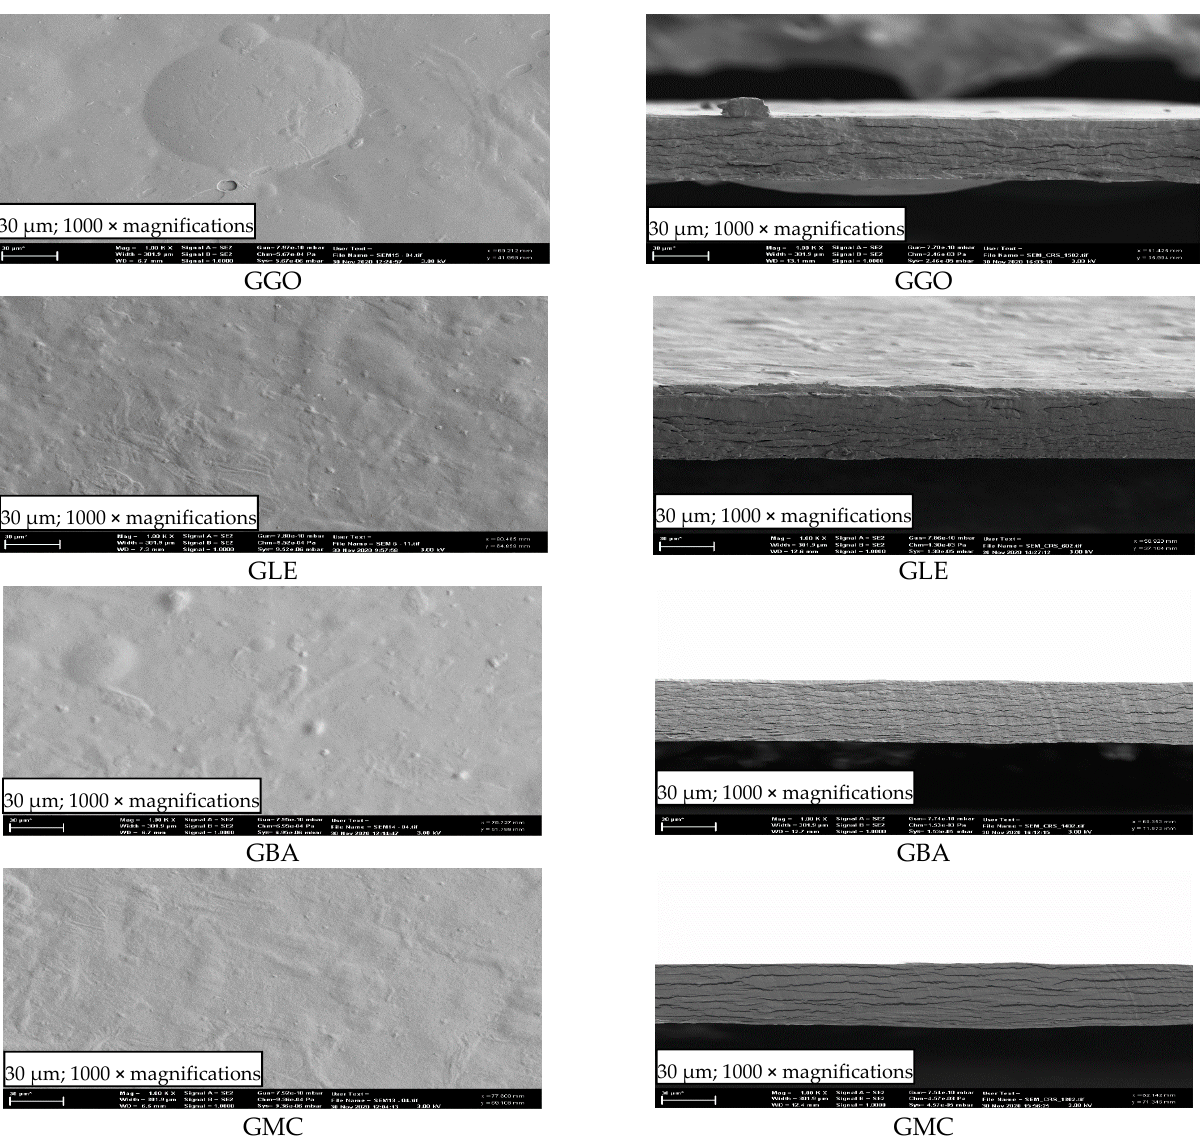
Figure 4. Scanning electron micrographs of the surface and cross-section of the gac pulp-based films.